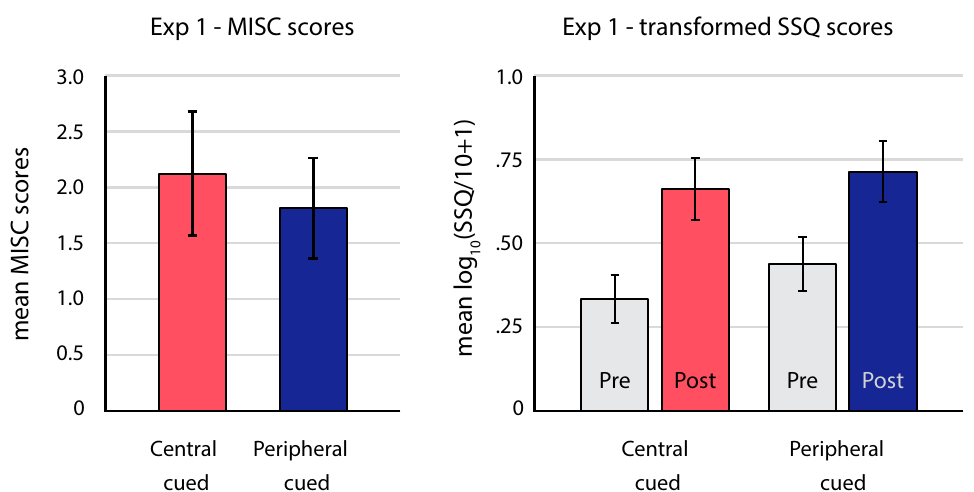
Fig. 4 Motion sickness in the central-cued (red) vs peripheral-cued (blue) conditions of Experiment 1. The left graph plots mean MISC scores. The right graph plots mean SSQ scores after transforming by log 10 (SSQ/10 errors of the mean